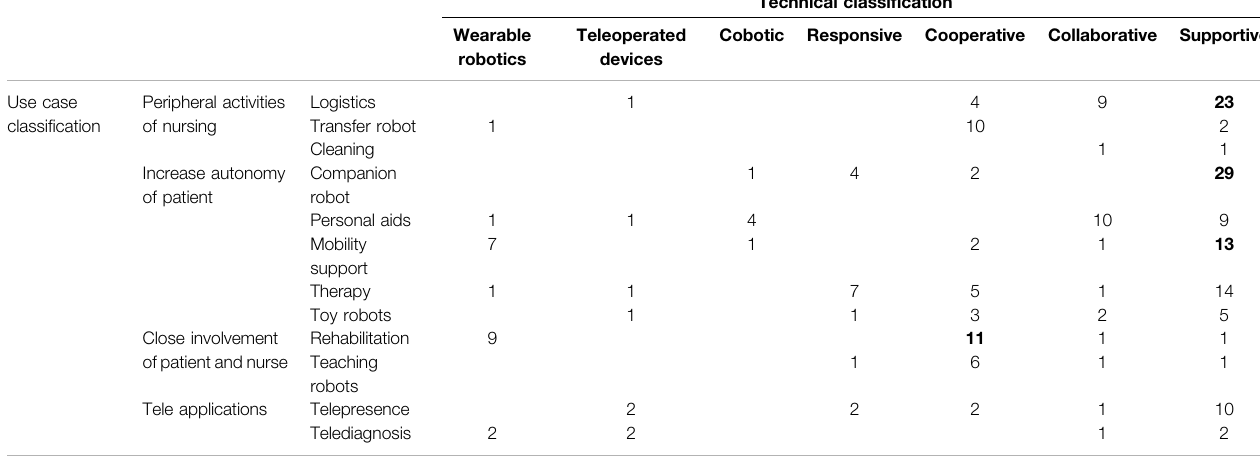
TABLE 1 | Technical vs. use case classi fi